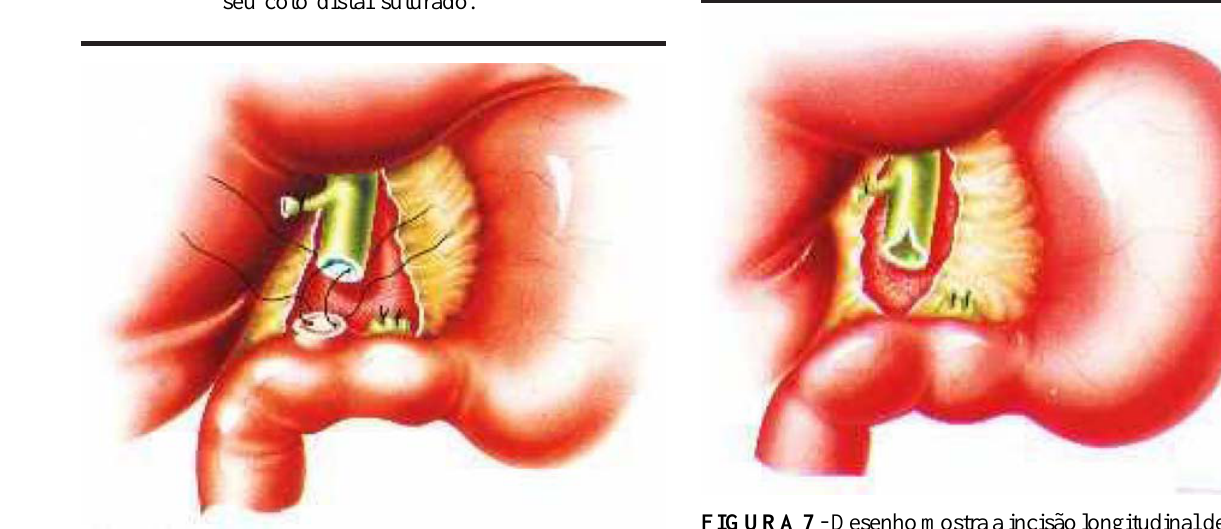
FIGURA 3 - Desenho mostra o colédoco seccionado com seu coto distal suturado.